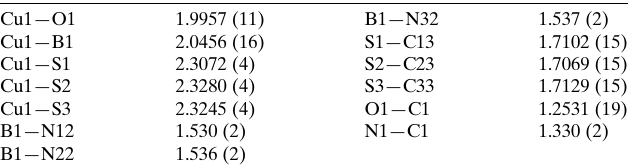
Table 1 Selected bond lengths (A˚